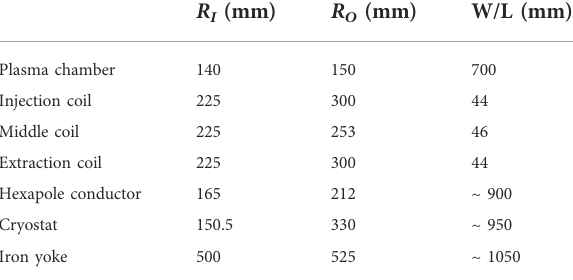
TABLE 1 Geometry of the PANDORA trap showing for each component: the inner radius ( R I ), the outer radius ( R O ), and the length or width ( L / W